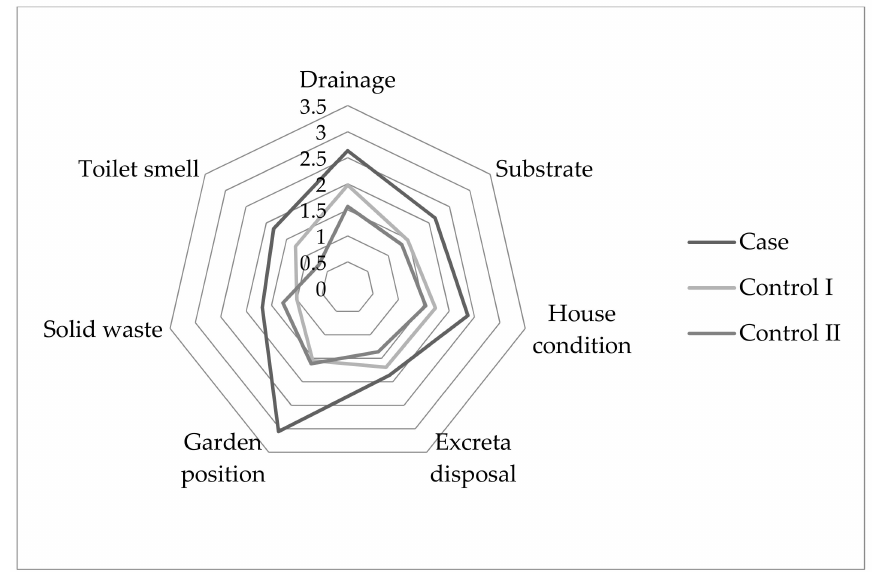
Figure 2. Mean rank of household living conditions for case versus controls in Central Division, Fiji based on a 0–4 rank of increased perceived likelihood of condition facilitating or indicating disease transmission. Only significant conditions are shown.